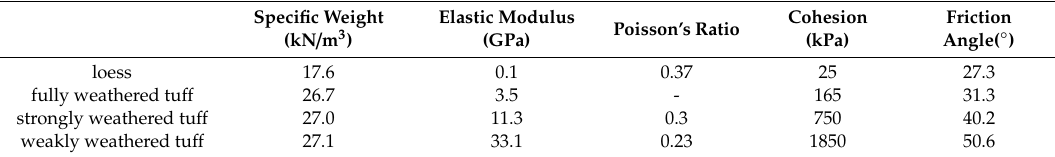
Table 1. The typical physical and mechanical properties of ground.